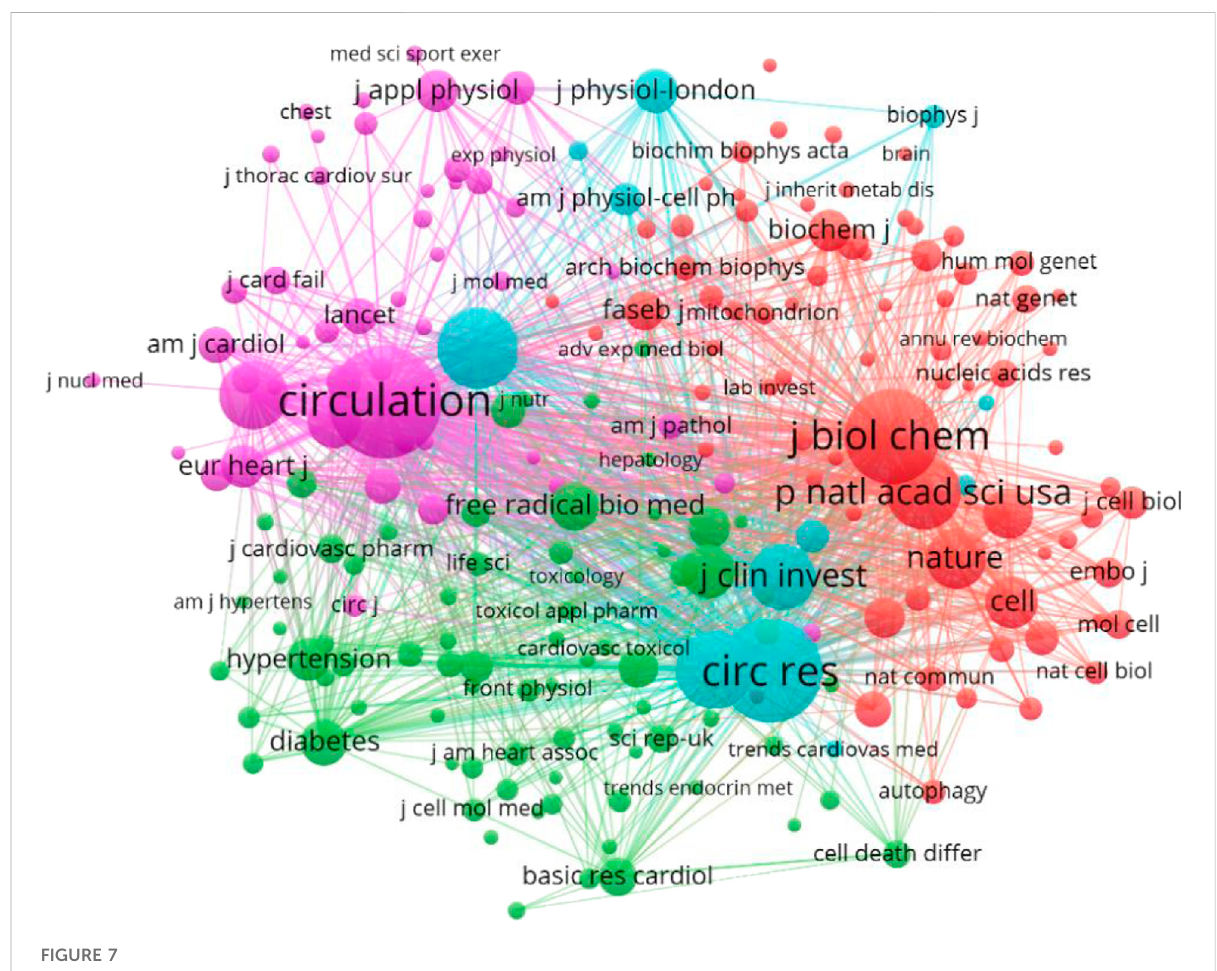
FIGURE 7 VOSviewer visualization map of co-cited journals.